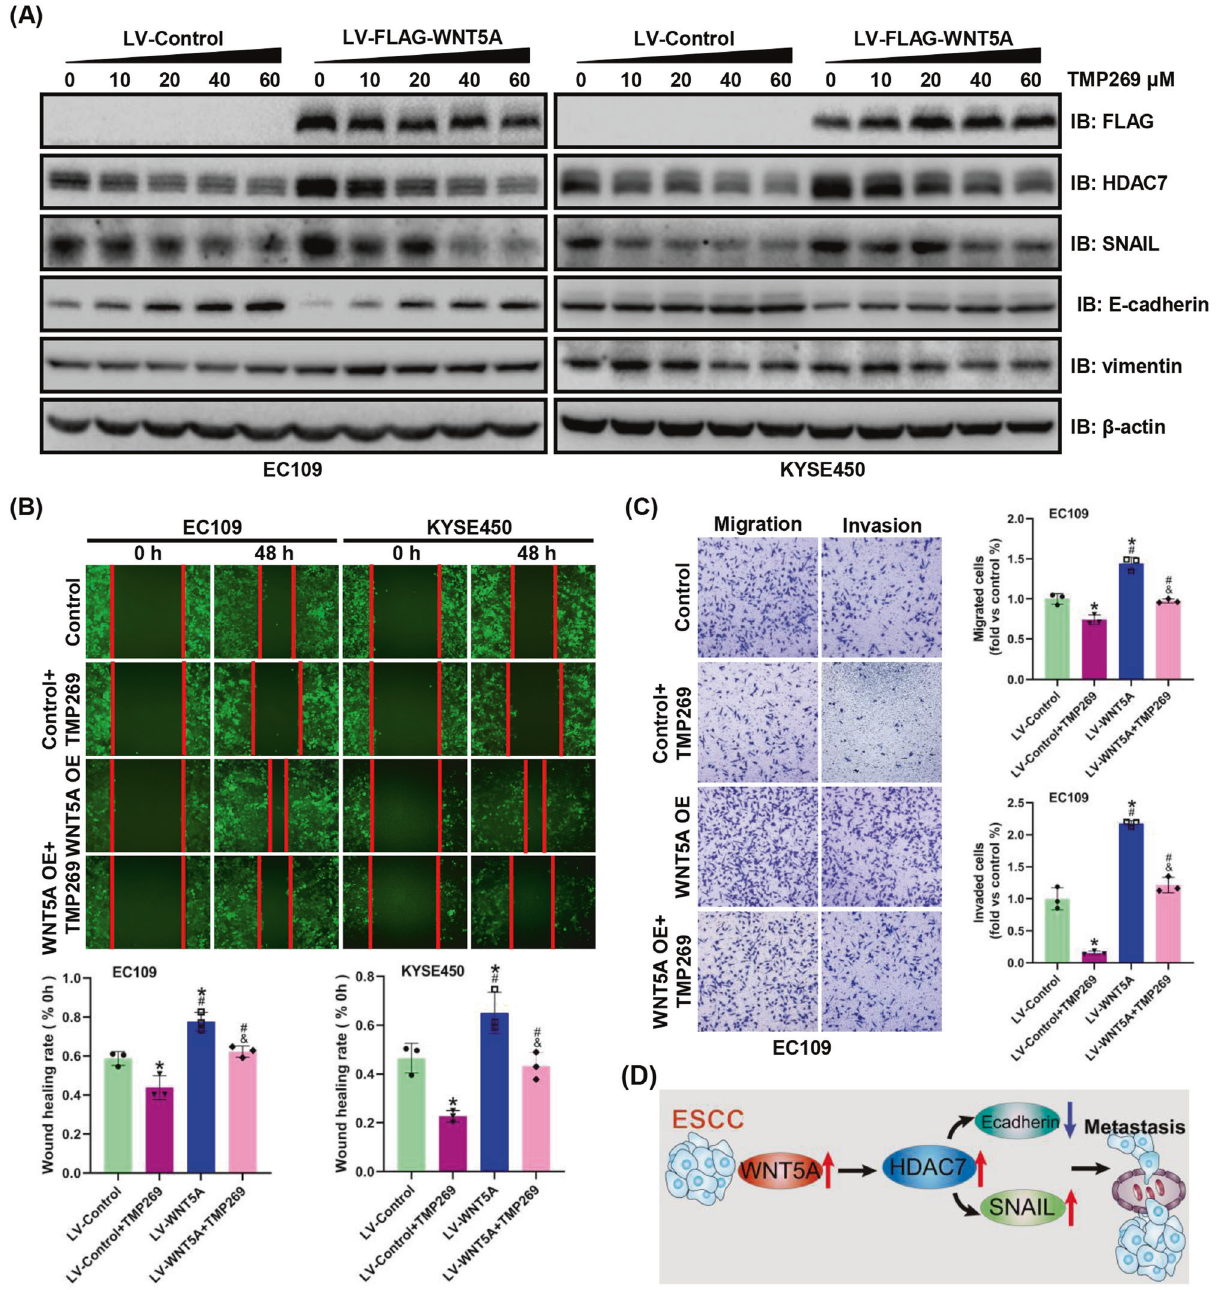
Fig. 7 TMP269 attenuates WNT5A-mediated ESCC cell migration and invasion. A Representative western blots showing the levels of FLAG- WNT5A, HDAC7, SNAIL, E-cadherin, and vimentin in WNT5A-overexpressing EC109 and KYSE450 cells after treatment with TMP269 for 48 h. β -actin was used as an internal control. B , C Representative images and statistical analysis of wound healing assays and Transwell migration/ invasion assays using WNT5A-overexpressing ESCC cells after treatment with TMP269 (20 μ M) for 48 h. The migratory ability in wound healing assays was expressed as the mean scratch area. The initial scratch area (0 h) was set to 100%. * P < 0.05 compared with the LV-Control group, # P < 0.05 compared with the LV-Control + TMP269 group, and & P < 0.05 compared with the LV-WNT5A group. LV lentivirus. D Schematic diagram of the mechanism by which WNT5A promotes tumor metastasis by activating the HDAC7/SNAIL signaling pathway in WNT5A, a typical WNT protein involved in an independent [27]. In the present study, our IHC analysis revealed signi fi cantly branch of β -catenin signaling, is highly conserved among species higher WNT5A expression in ESCC tissues than in adjacent and plays key roles in embryonic development, internal home- noncancerous tissues and that high WNT5A expression was ostasis, and pathological disorders. WNT5A can stimulate the related to a high TNM and N stage. Additionally, the cumulative noncanonical WNT pathway and the canonical WNT signaling survival rate results indicated that high WNT5A expression was pathway by either activating or antagonizing it [28]. Several associated with shorter overall survival of patients with ESCC. The studies reported that WNT5A was upregulated in breast carcino- multivariate Cox survival analysis suggested that WNT5A was a mas, prostate carcinomas, and melanoma, indicating its oncogenic negative prognostic factor for patients with ESCC.